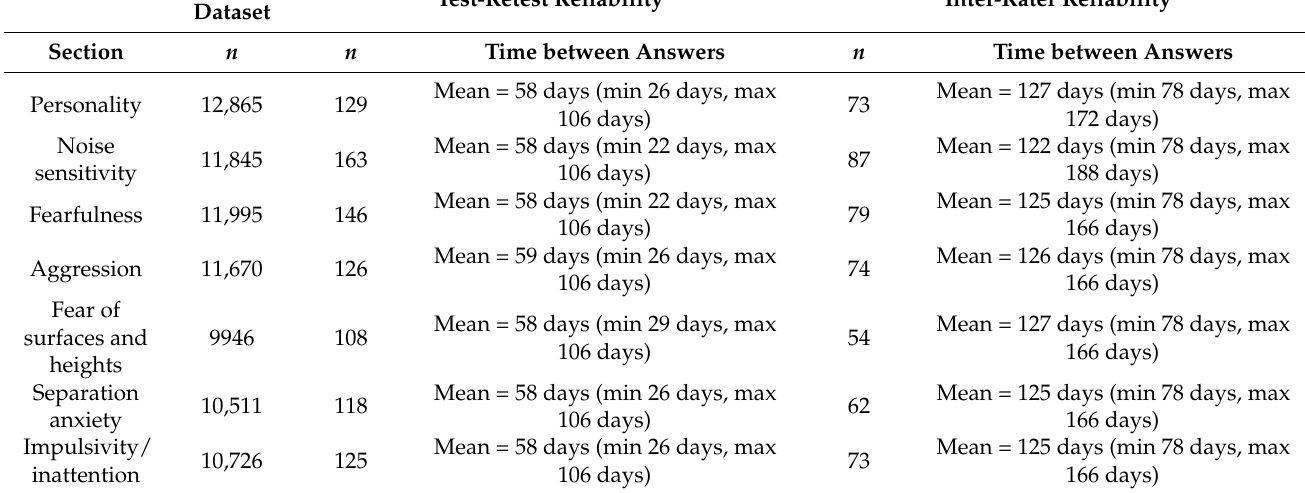
Table 1. Number of dogs in the whole datasets, and the number of dogs and time between answers in the test-retest reliability datasets and inter-rater reliability